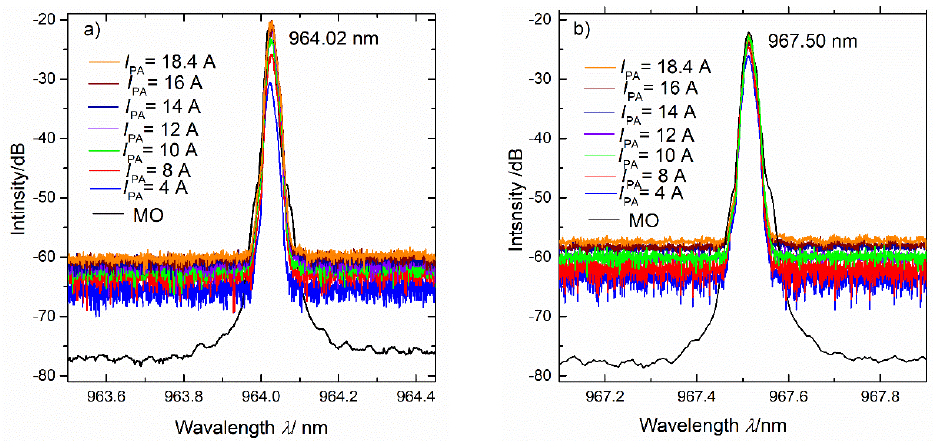
Figure 7. Time-averaged optical spectra of the MO (black curves) and the MOPA (colored curves) for different pulse currents as indicated in the legends emitted by the left ( a ) and right ( b ) branches of the Y ‐ DFB laser.